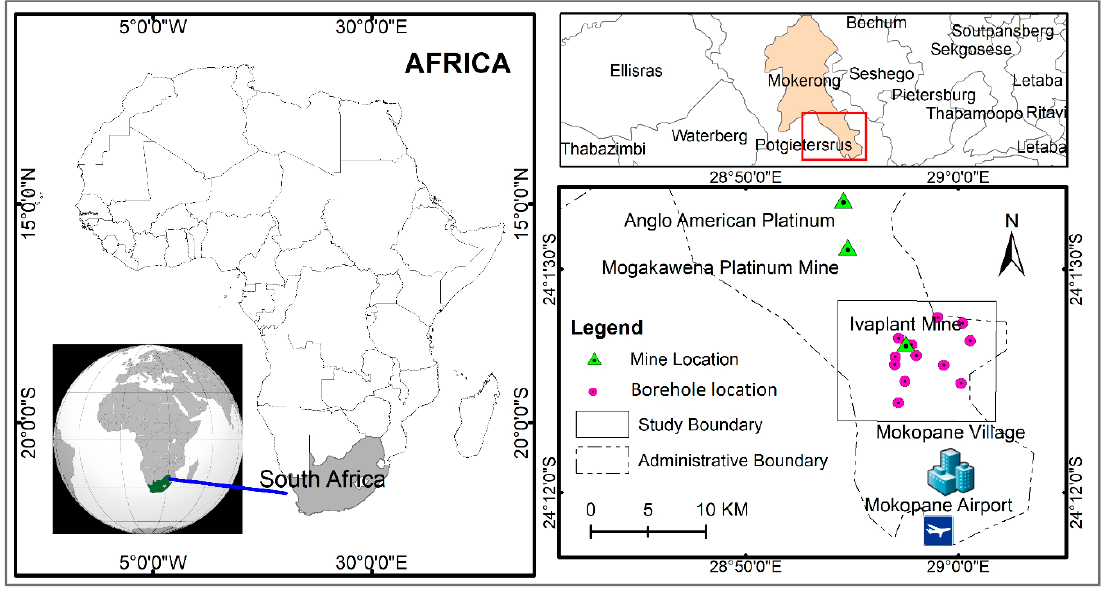
Figure 1. Location of the study area sampling points and mining sites.